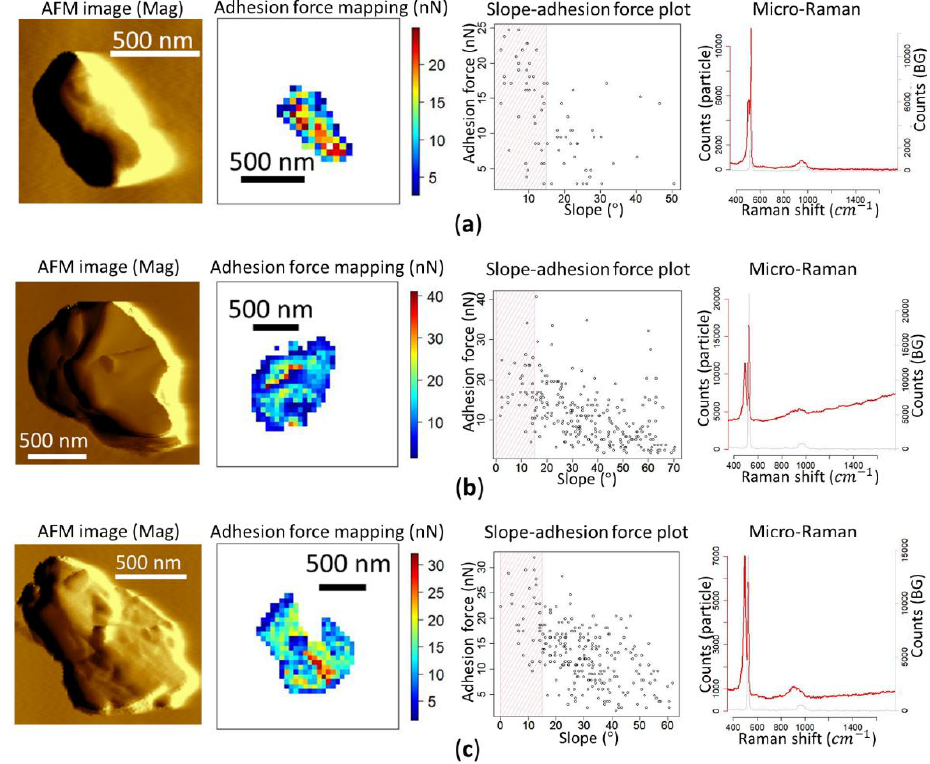
Figure 3. Atomic force microscopy (AFM) mag images, adhesion force mapping images, slope – adhesion force plots, and micro-Raman spectrums of model dust particles: ( a ) quartz, ( b ) CJ-1, and ( c ) ATD. Corresponding AFM height and phase images can be found in Figure S3 in the Supplementary